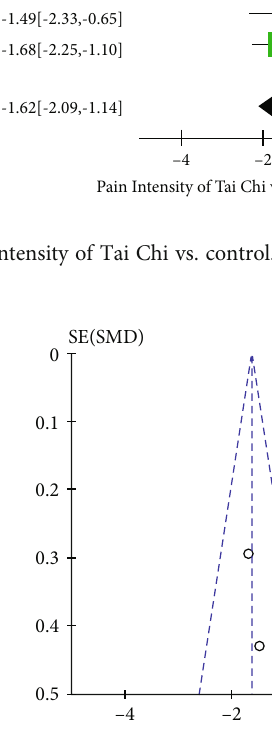
Figure 9: Funnel plot of pain intensity of Tai Chi vs.